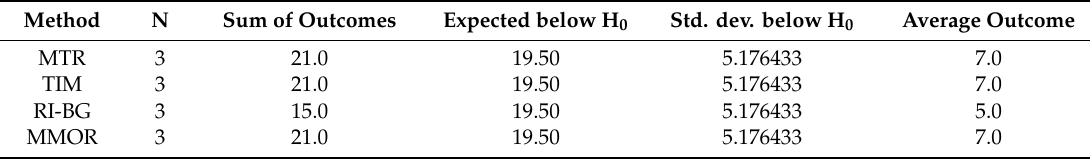
Table 19. Wilcoxon’s assessment (sums of ranks) for results obtained using the four